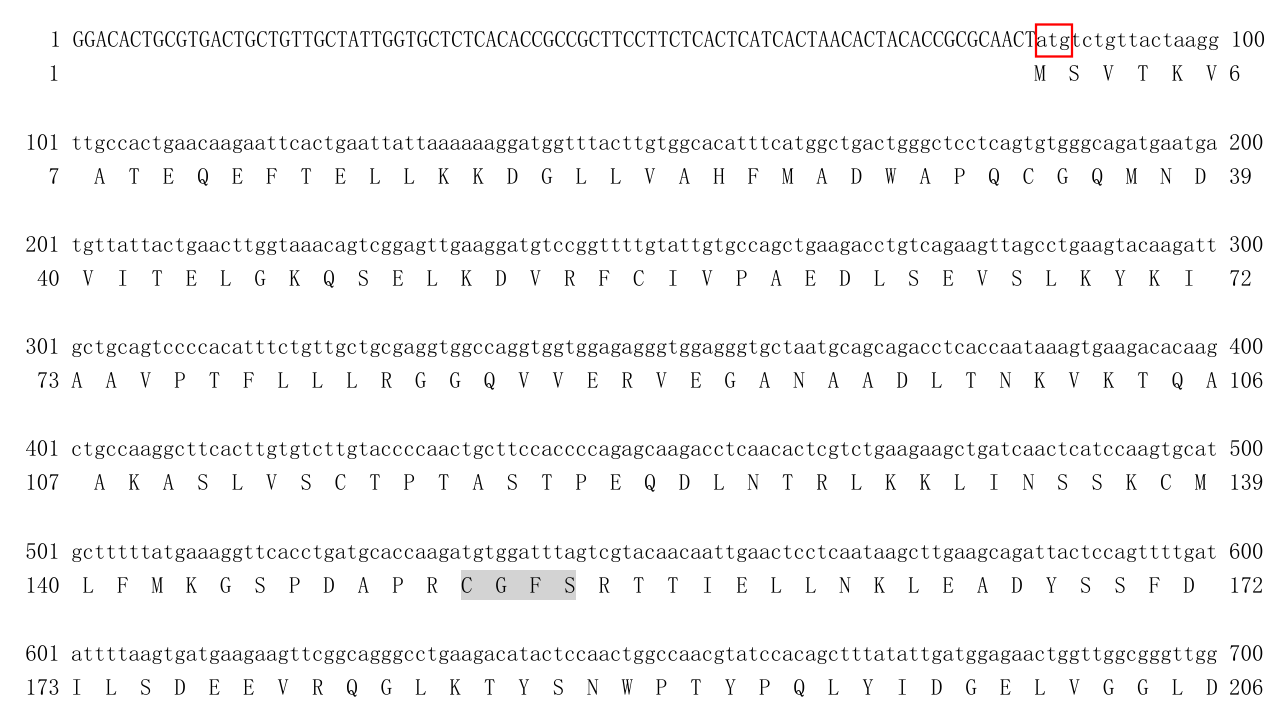
The complete nucleotide and deduced amino acid sequence of SpGrx3 are shown in Figure 1. The full-length SpGrx3 contains a 129-bp 5 (cid:48) untranslated region, a 1,183-bp 3 (cid:48) untranslated region, and a 981-bp ORF encoding a 326 amino acids protein with a predicted molecular weight of 36.17 kDa and a predicted isoelectric point (pI) of 5.12 (GenBank accession number: OK639196). Two active sites of the monothiol Grx C-G-F-S (151–154 and 253–256 aa) and three conserved domains (an N-terminal thioredoxin domain and two C-terminal glutaredoxin domains) were predicted (Figure 2A), indicating that SpGrx3 is a member of the Grx family [7].